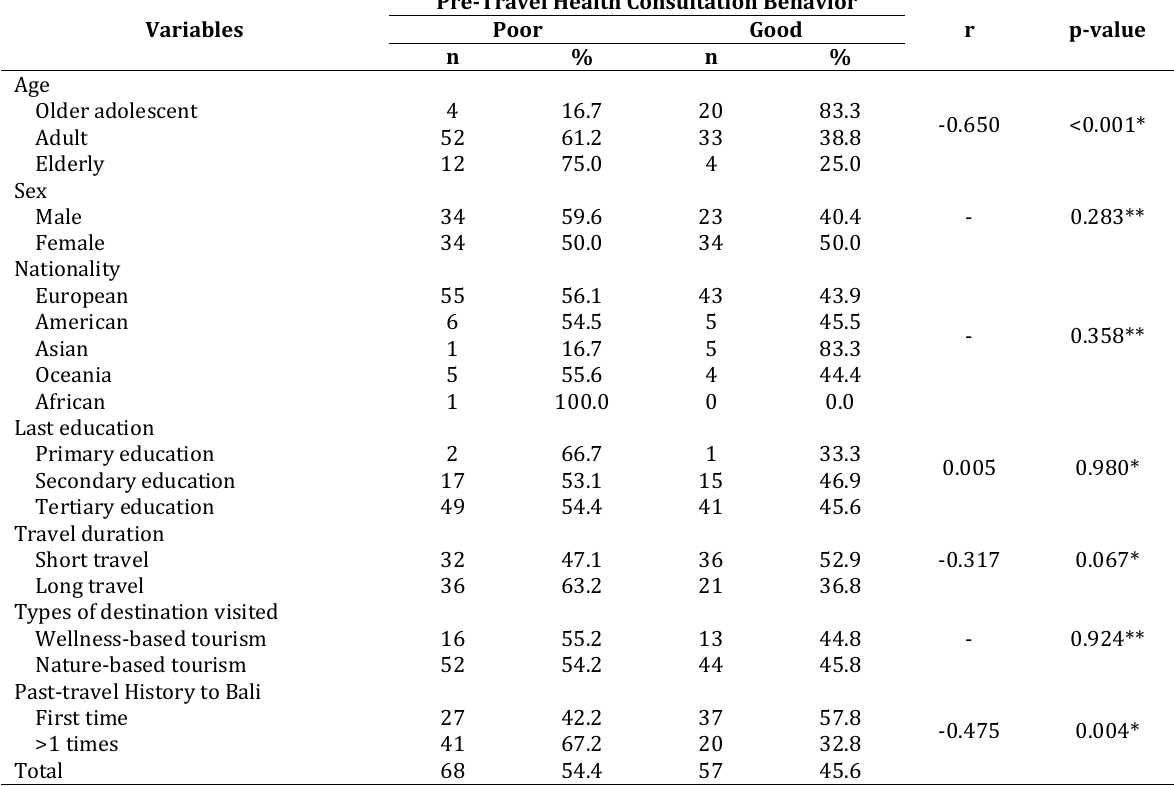
Table 3. The Relationship of Sociodemography and Itinerary Characteristics among International Travelers in Badung. Bali in 2020 (n=125)